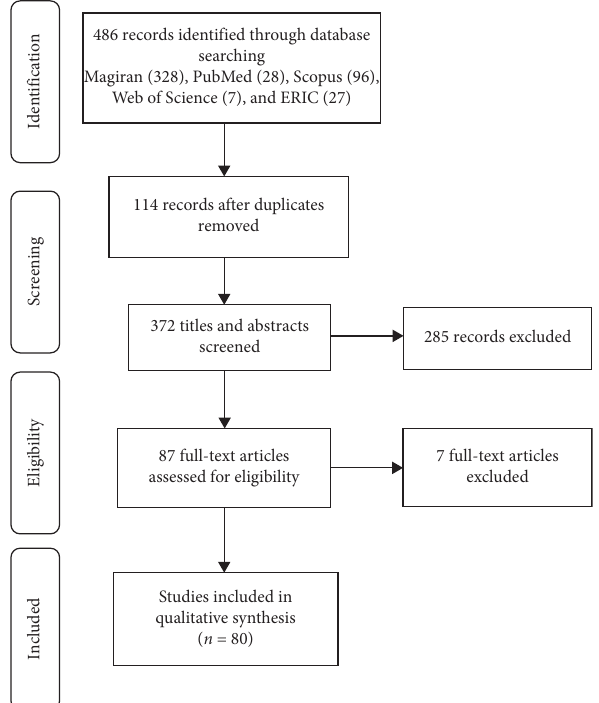
Figure 1: Flowchart of the selection and reviewing of